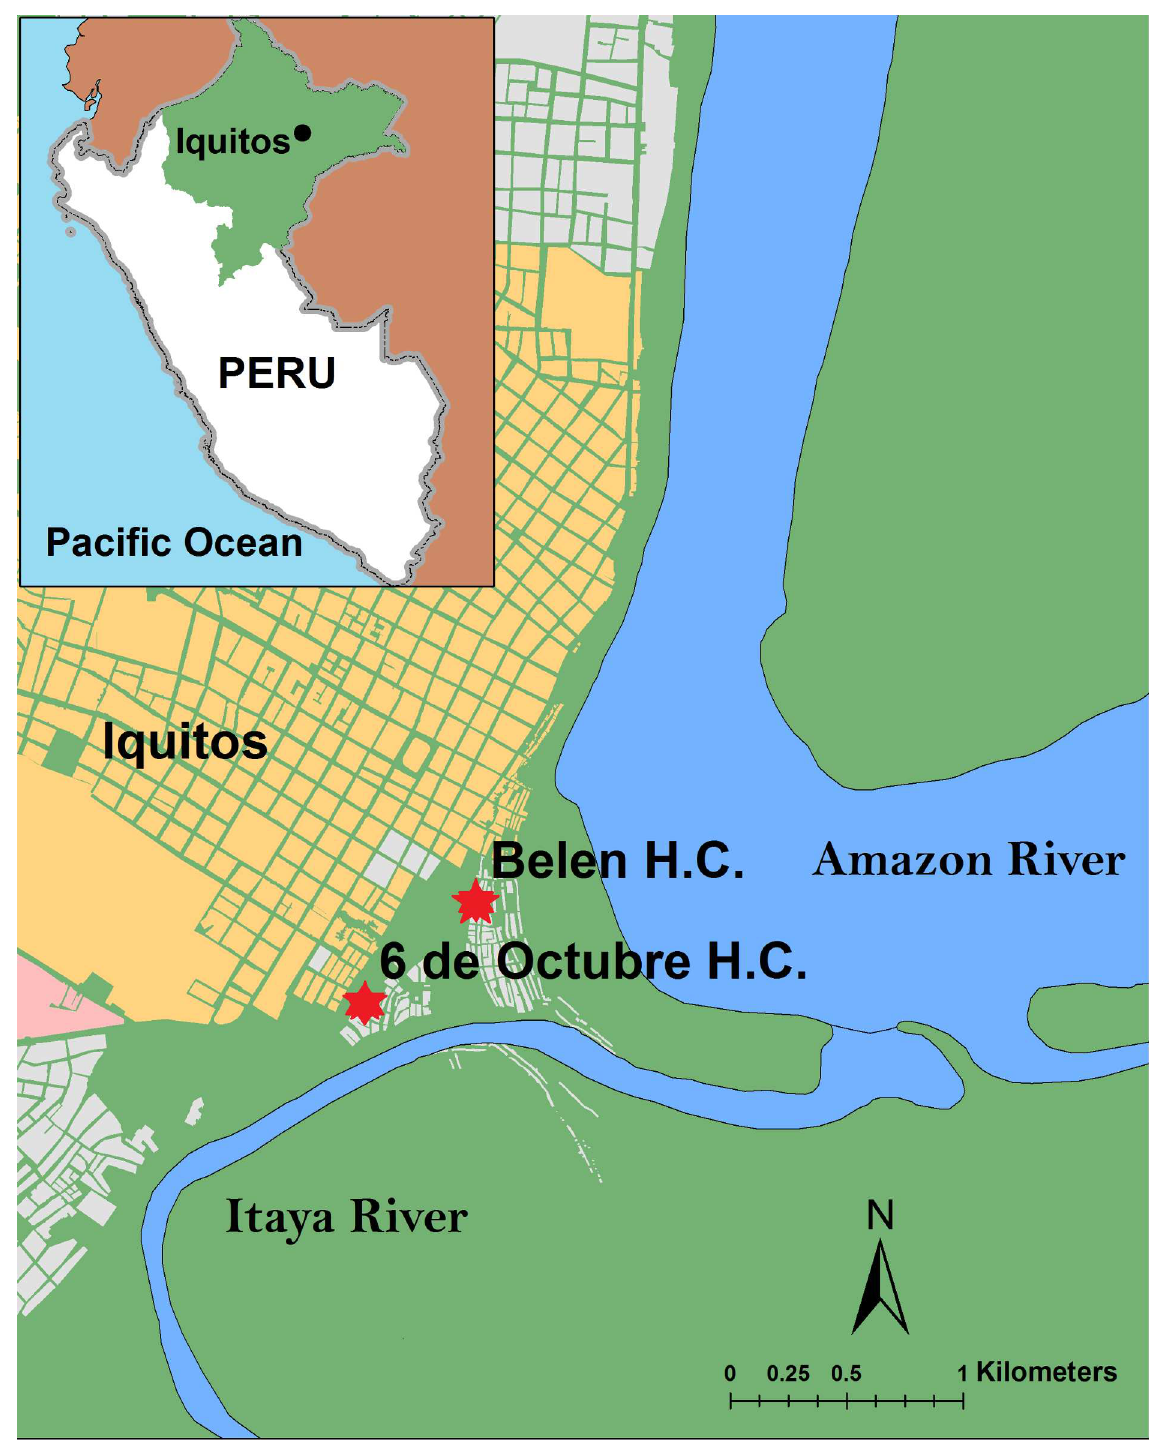
Fig 1. Map of study area in the northern Amazon region of Peru. Red stars show the locationof the two study health centres (H.C.).